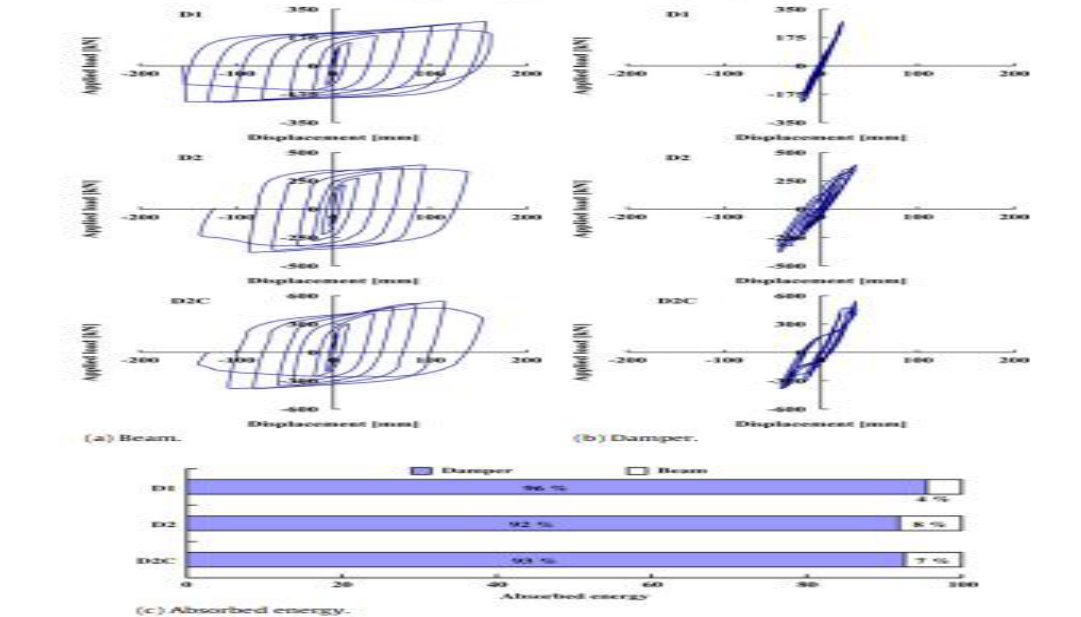
Figure 11. Loops of a damper of the beam and dissipate of absorbed